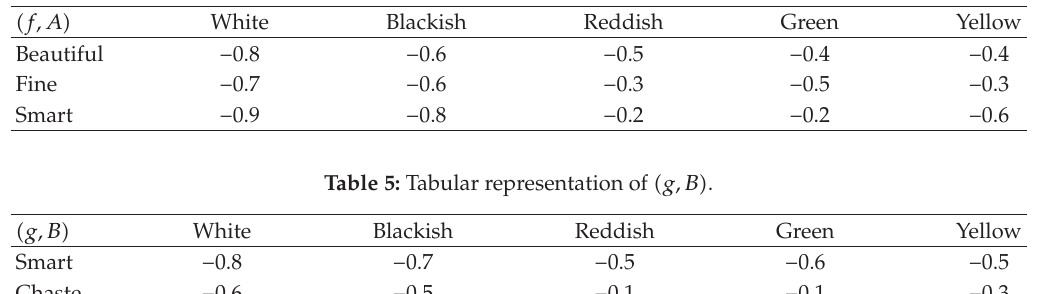
Table 4: Tabular representation of (cid:2) f,A (cid:3) .